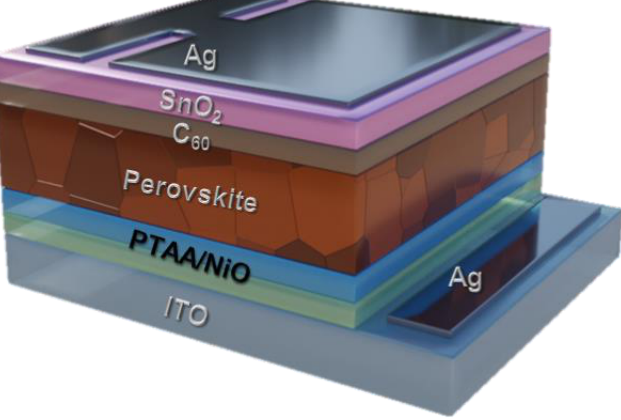
Figure 2. Structural layout of PTAA/NiO-based PSCs. Based on this structure, the outputs of PSCs and various electrical and optical perfor- mances were analyzed. The current–voltage (J–V) curves and external quantum efficiency (EQE) of the best NiO and PTAA/NiO bilayer-based PSCs are shown in Figure 3. As presented in Figure 3a, the PTAA/NiO bilayer-based PSC significantly improved PCE from 17.29% to 19.05%, and V OC , J SC and FF all increased from 1.10 V to 1.15 V, from 20.93 mA cm − 2 to 21.69 mA cm − 2 , and from 74.73% to 76.47% %, respectively, as listed in Table 1. As shown in Figure 3b, the optimized PTAA/NiO bilayer exhibited higher EQE values compared to NiO devices, which supports that devices with PTAA/NiO bilayer promote efficient charge extraction and higher Voc [40]. The device performance improve- ment was consistent with the J–V and EQE spectra of NiO and PTAA/NiO bilayer-based PSCs. The J SC calculated by integrating the EQE curves (20.30 mA cm − 2 for NiO-based and 21.08 mA cm − 2 for PTAA/NiO) showed a small deviation (3%) from the J SC obtained from the J–V curves, thus indicating that the measurements are reliable. Table 1. Device performance of the NiO monolayer and PTAA/NiO bilayer-based PSCs under AM